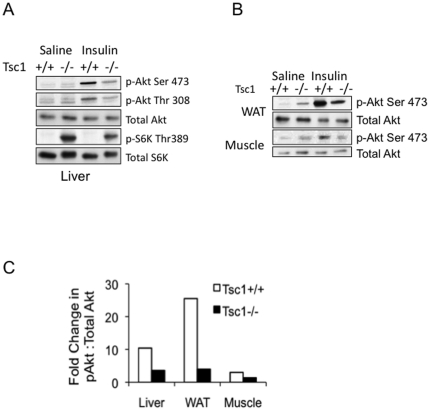
Liver, fat and muscle of Tsc1−/− mice show blunted response to insulin.Following an eight-hour fast, mice were injected with 0.5 U/kg of insulin or saline (control) for 10 minutes before sacrifice. A) Liver and B) white adipose tissue (WAT) and skeletal muscle tissue lysates were analyzed for the expression of indicated proteins. C. Akt response to insulin. The relative band intensities of p-Akt(Ser473) were normalized to total Akt from (A) and (B), and then the ratios between the insulin- and saline-treated animals were calculated from individual tissues tested.